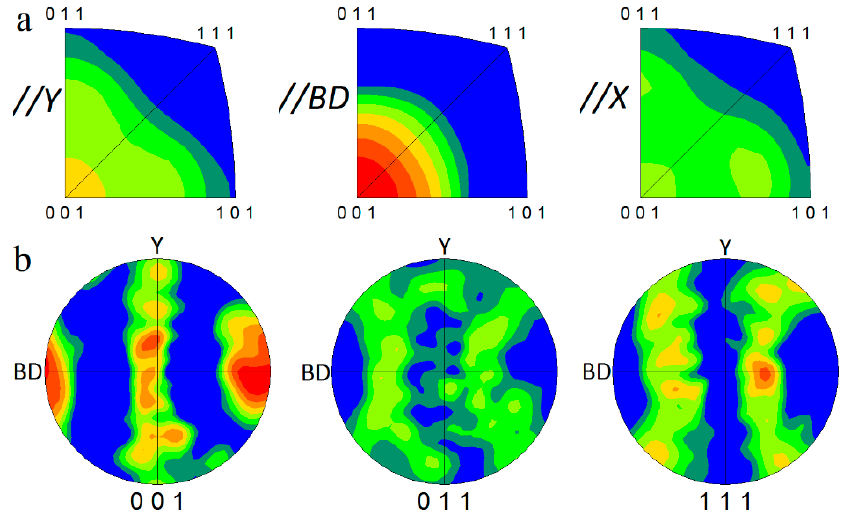
Figure 15. ( a ) Inverse pole figures parallel to x, y, and BD directions in conjunction with ( b ) (001), (011), and (111) pole figures (PFs) of as-built L-PBF AlSi10Mg. The rotated (001), (011), and (111) pole figures of the SZ-I and SZ-II areas in the 1–3